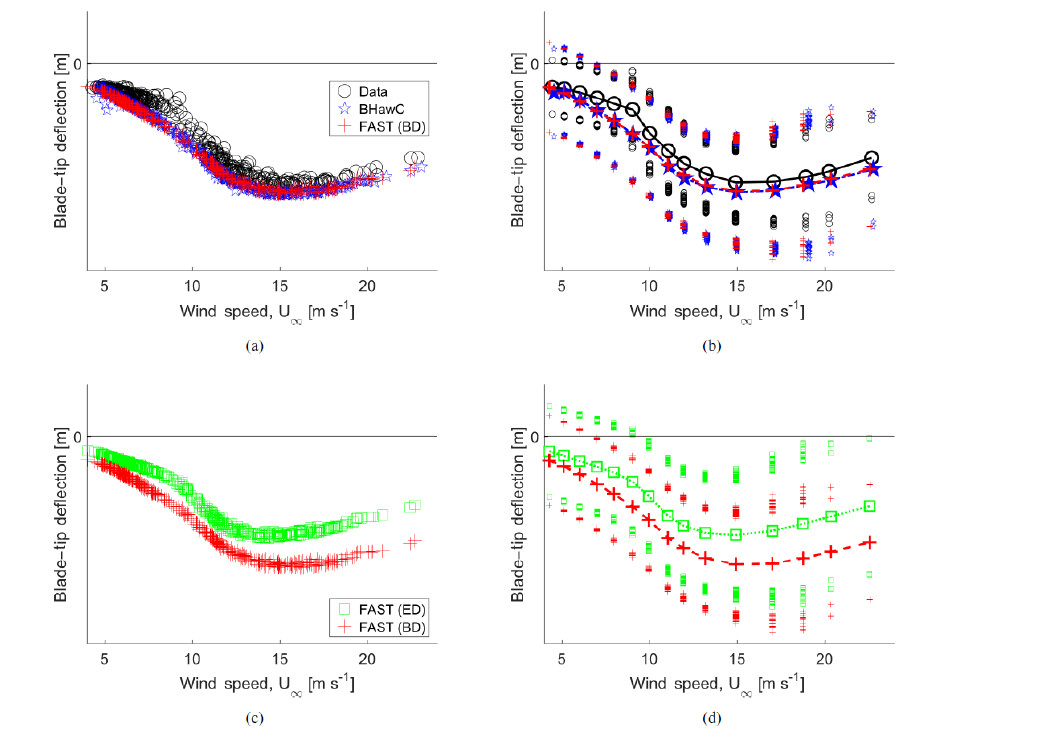
Figure 4. Blade in-plane tip deflections. (a) Individual 10min averages from experimental data, BHawC, and FAST (BD). (b) Binned averages of data in (a) are denoted by points connected by lines; the scatter above and below these data denotes plus or minus 1 standard deviation, respectively, of the individual 10min data sets in that bin. (c) Individual 10min averages from FAST (BD) and FAST (ED). (d) Binned averages of data in (c) are denoted by the points connected by lines; the scatter above and below these data denotes plus or minus 1 standard deviation, respectively, of the individual 10min data sets in that